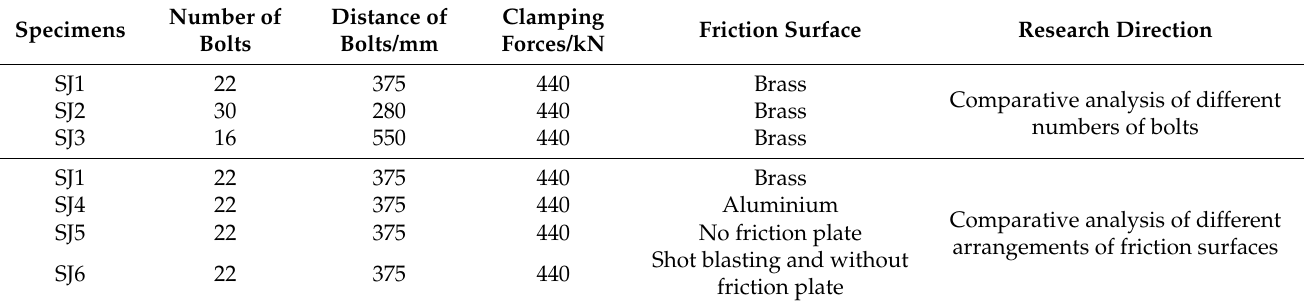
Table 1. The details of the friction energy dissipation composite chord specimens.